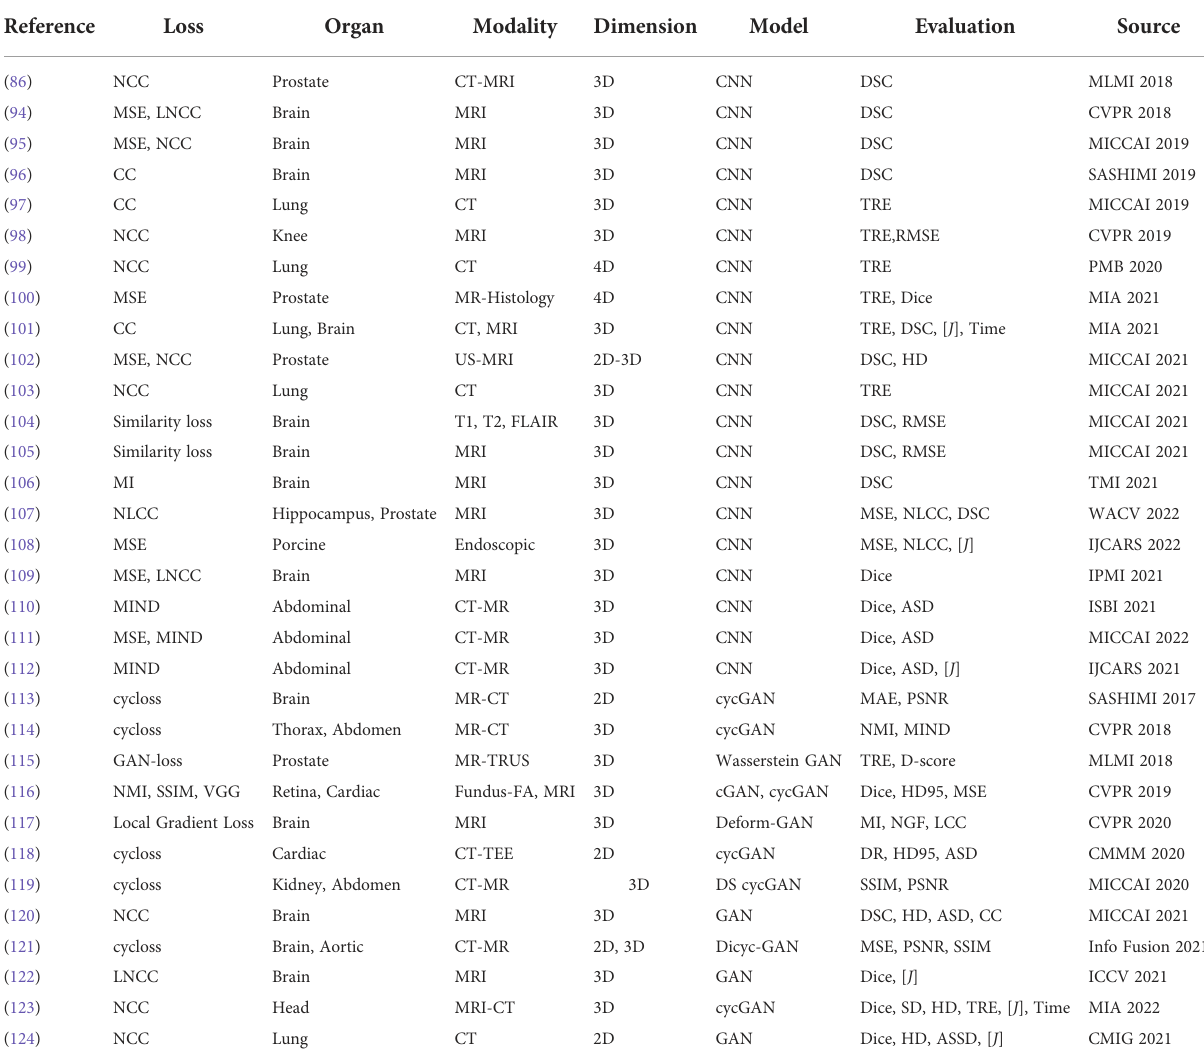
TABLE 4 Unsupervised medical image registration methods.